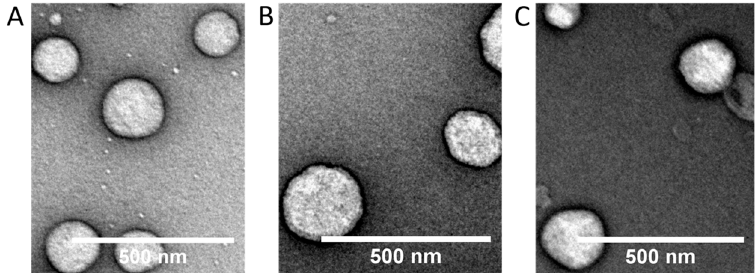
Figure 2. Transmission electron microscopy (TEM) images of nanocapsules ( A ) unloaded ( B ) NC_TIO ( C ) NC_ECO. Scale bar: 500 nm.